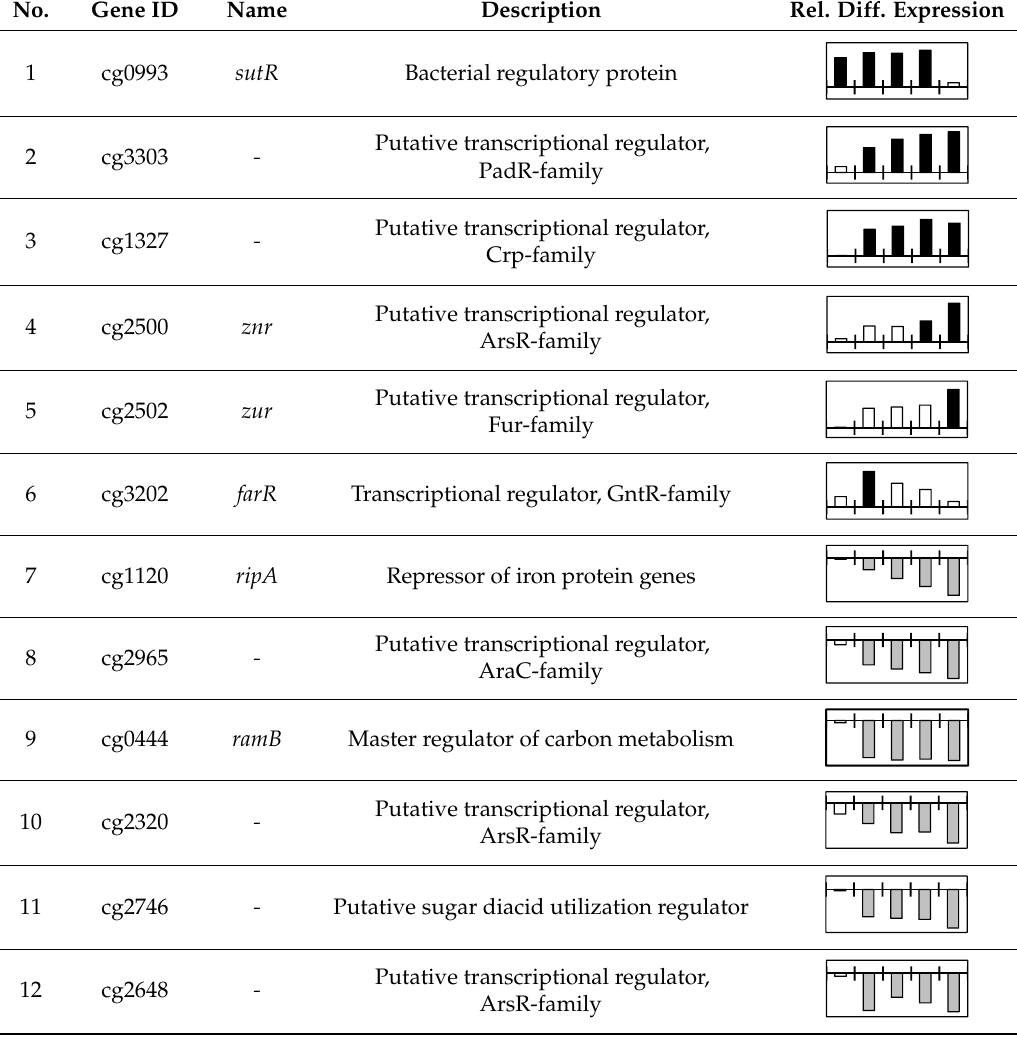
Table A3. Relative differential expression of putatively oxygen responsive regulators. Description based on literature [98,103]. Column graphs represent log 2 -fold changes of enhanced (black) and reduced (grey) expression. Open columns are values outside the significance constraints ( m -value > 1.50, < − 1.50 and a -value > 1.00). From left to right aerobiosis ( 2 (cid:13) ), microaerobiosis ( 3 (cid:13) , 4 (cid:13) , 5 (cid:13) ) and anaerobiosis ( 6 (cid:13) ) versus the aerobic reference ( 1 (cid:13) ; Figure 1A). Scaling of these graphs is variable. Table A3. outside the significance anaerobiosis ( ⑥ ) versus the aerobic reference ( ① ; Figure 1A). Table A3. outside the significance anaerobiosis ( ⑥ ) versus the aerobic reference ( ① ; Figure 1A). Table A3. outside the significance anaerobiosis ( ⑥ ) versus the aerobic reference ( ① ; Figure 1A). Table A3. outside the significance anaerobiosis ( ⑥ ) versus the aerobic reference ( ① ; Figure 1A). Table A3. outside the significance anaerobiosis ( ⑥ ) versus the aerobic reference ( ① ; Figure 1A). Table A3. outside the significance anaerobiosis ( ⑥ ) versus the aerobic reference ( ① ; Figure 1A). Table A3. outside the significance anaerobiosis ( ⑥ ) versus the aerobic reference ( ① ; Figure 1A). Table A3. outside the significance anaerobiosis ( ⑥ ) versus the aerobic reference ( ① ; Figure 1A). Table A3. outside the significance anaerobiosis ( ⑥ ) versus the aerobic reference ( ① ; Figure 1A). Table A3. outside the significance anaerobiosis ( ⑥ ) versus the aerobic reference ( ① ; Figure 1A). Table A3. outside the significance anaerobiosis ( ⑥ ) versus the aerobic reference ( ① ; Figure 1A). Table A3. outside the significance anaerobiosis ( ⑥ ) versus the aerobic reference ( ① ; Figure 1A). No. Name Description Rel. Diff. Expression No. Rel. Diff. Expression No. No. No. No. No. No. No. No. No. No. Bacterial regulatory protein